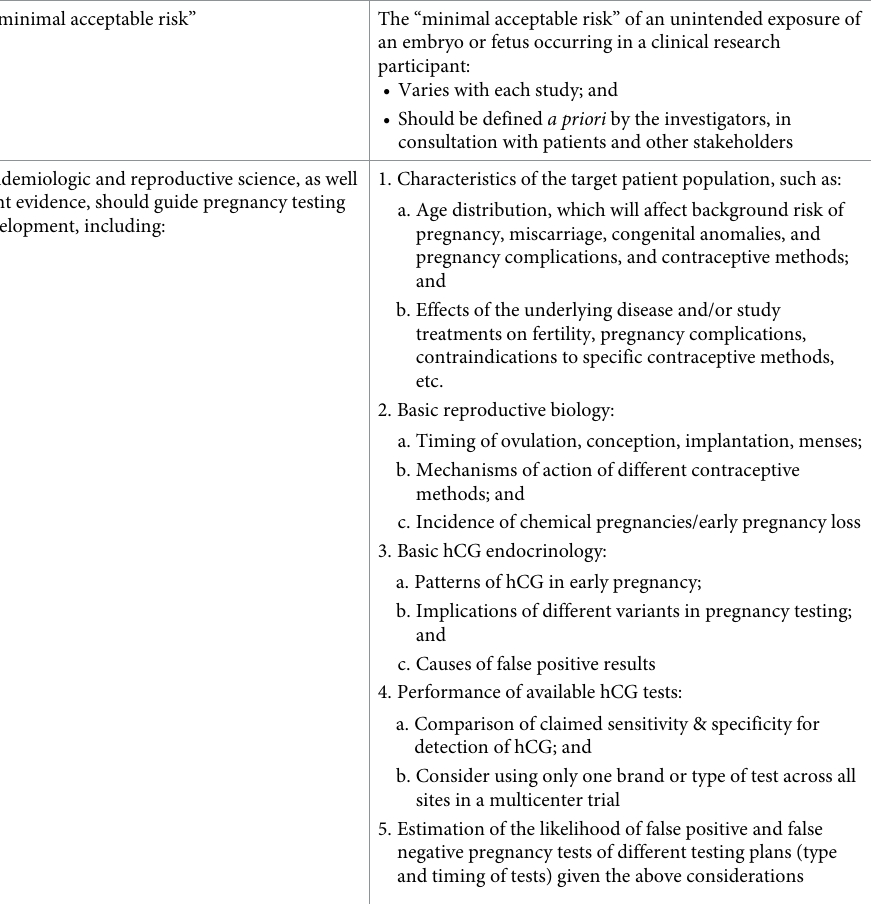
Table 3. General